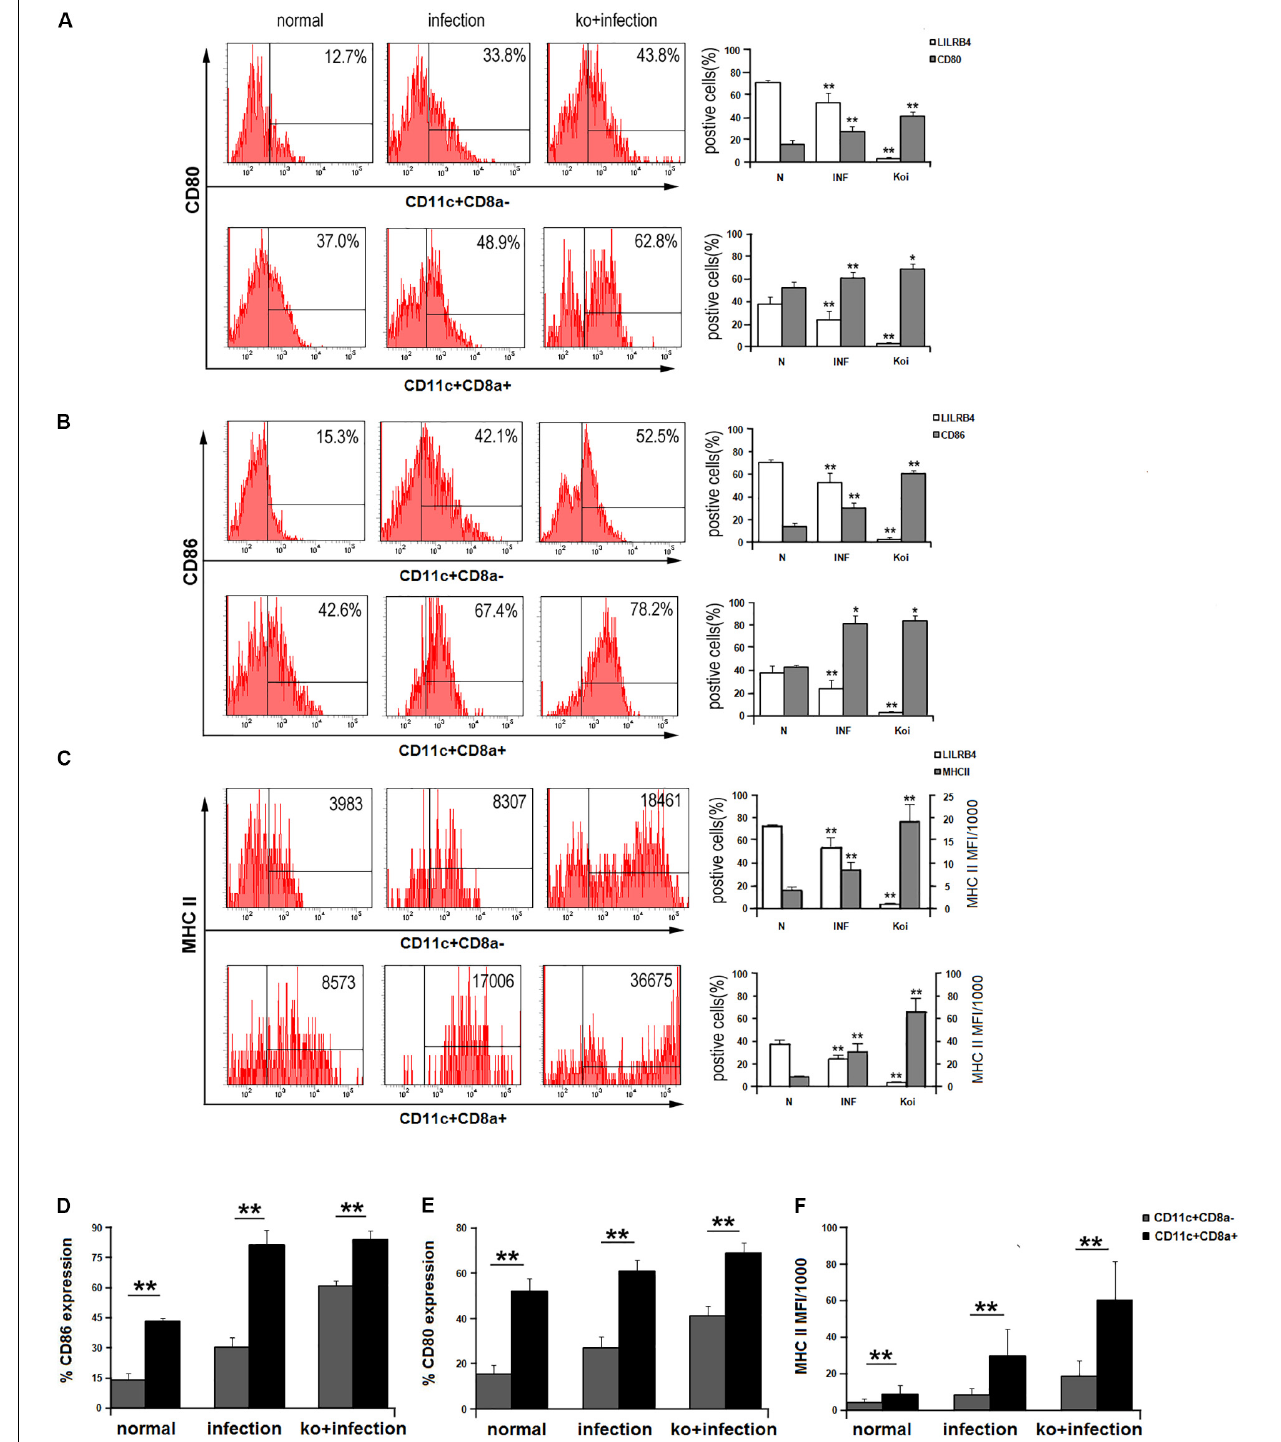
FIGURE 5 | Down-regulation of LILRB4 on mice uDC subsets with T. gondii infection resulted in changes in the expression of functional molecules of mice uDCs. CD80 (A) , CD86 (B) , and MHC II (C) followed LILRB4 expression on CD11c + CD8a + and CD11c + CD8a − uDC subsets was analyzed from normal, infected, and LILRB4 − / − infected mice using flow cytometry and histograms. Changes in the expression of CD80 (D) , CD86 (E) , and MHC II (F) followed LILRB4 on CD11c + CD8a + and CD11c + CD8a − uDC subsets were compared in normal, infected, and LILRB4 − / − infected mice. Data are expressed as means ± SD ( ∗ p < 0.05, ∗∗ p < 0.01). Representative data from 10 independent experiments for each group.